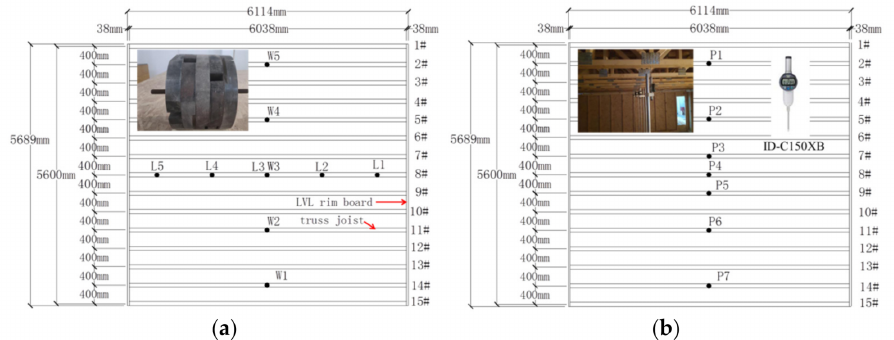
Figure 5. Distributions of the loading points ( a ) and monitoring points ( b